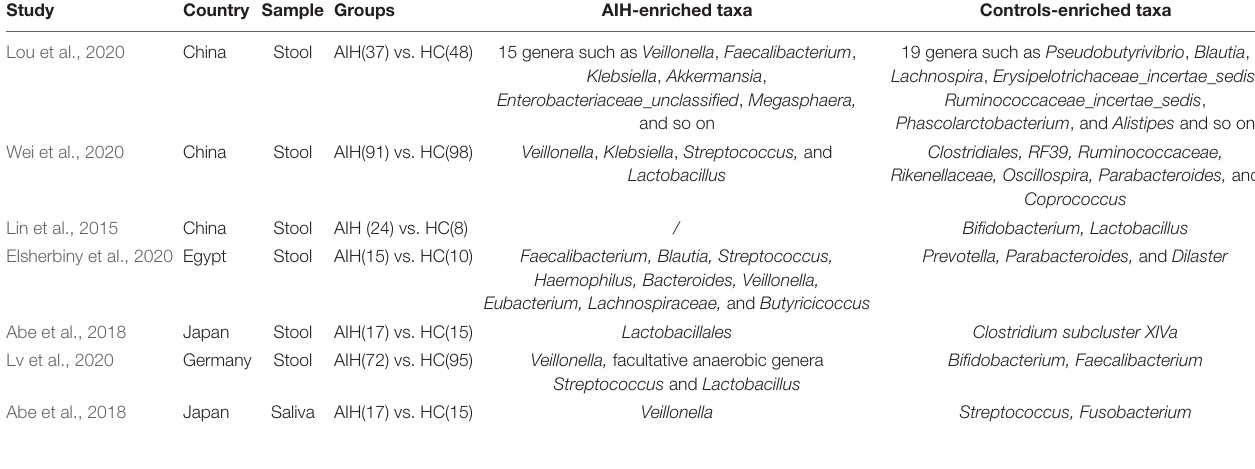
TABLE 2 | Study of microbiome in autoimmune hepatitis